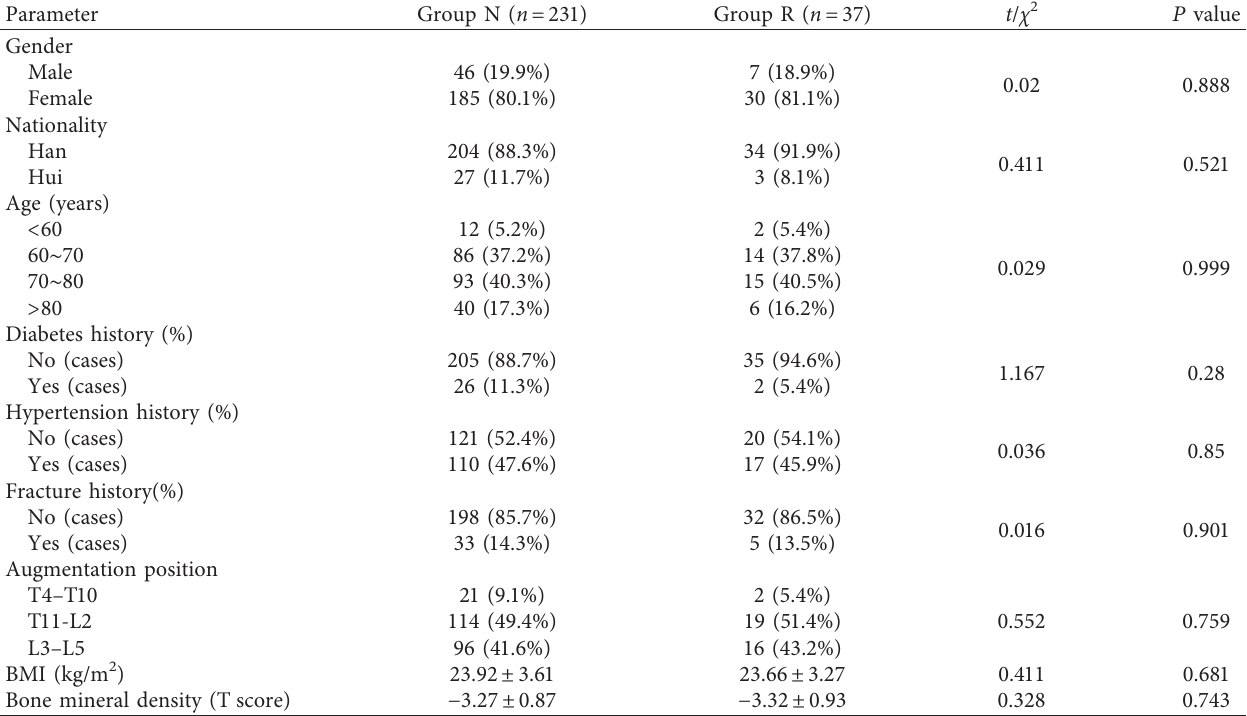
Table 2: Comparisons of baseline between patients between group N and group R.